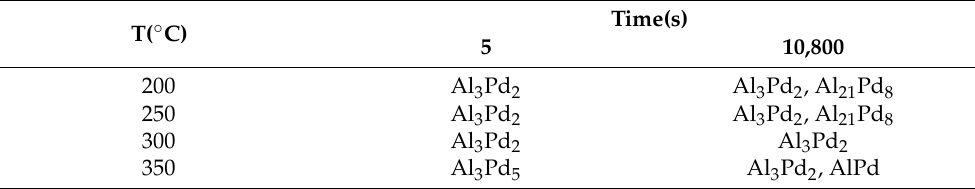
Table 1. Interfacial intermetallic compounds generated under different annealing conditions for Pd/Al composite wires.